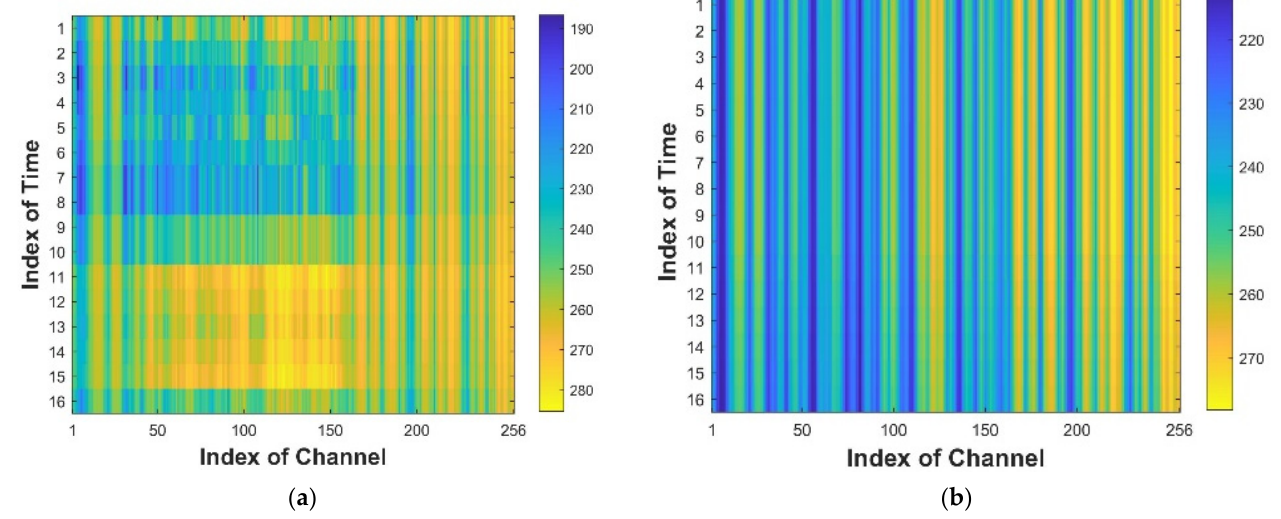
Figure 3. ( a , b ) Time of data: 09:00–24:00 on 7 December 2020. Location of data: latitude 16 ° and longitude 74 ° . Wavenumber: 1650–1809.375 cm − 1 ( a ) GIIRS-observed brightness temperature; ( b ) simulated brightness temperature of GFS data input into RTTOV. The color bar indicates the brightness temperature (K) represented by the different colors.